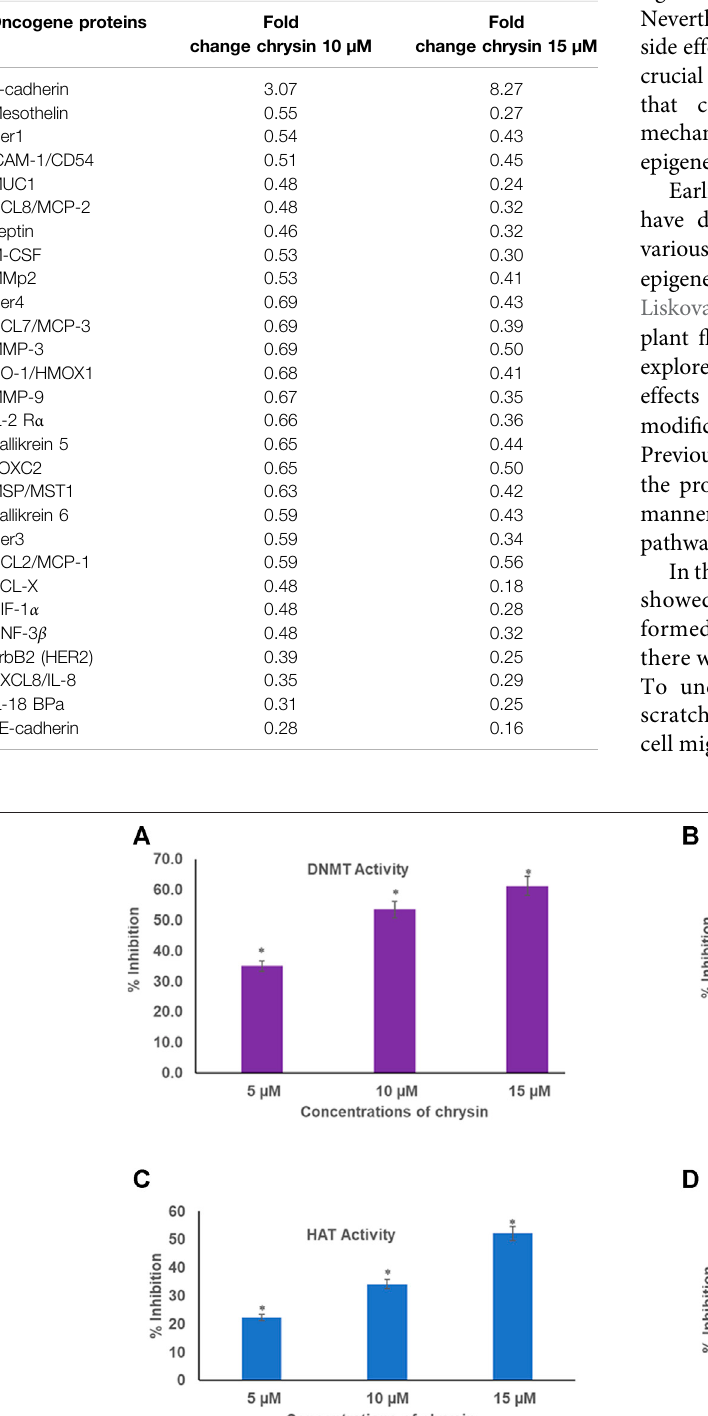
Frontiers in Genetics |